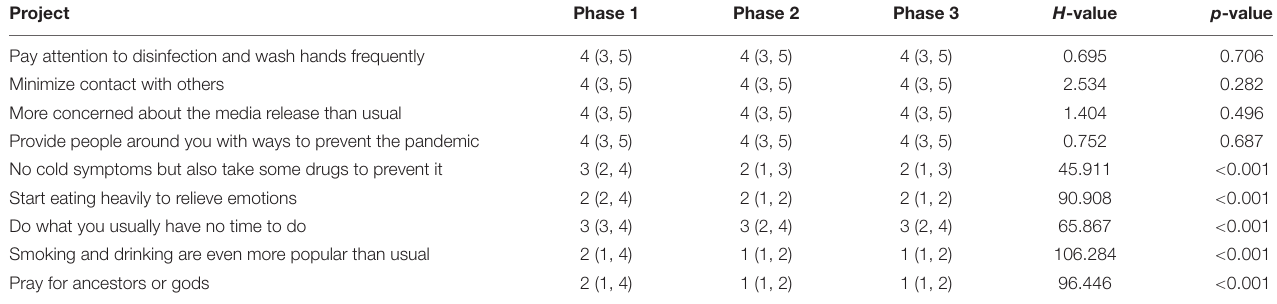
TABLE 6 | Behavior change scale for college students and Kruskal–Wallis H test score in three stages of pandemic [Points, M (P25, P75)]. Project